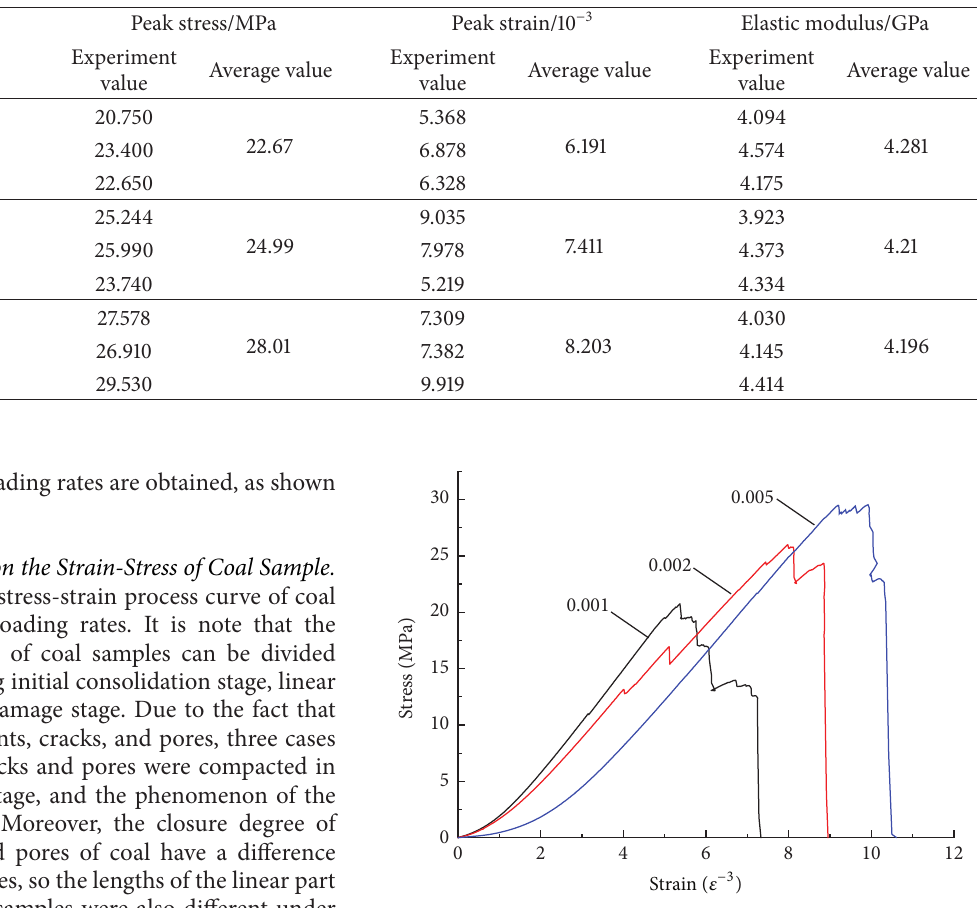
Table 1: Mechanical parameters of coal samples.